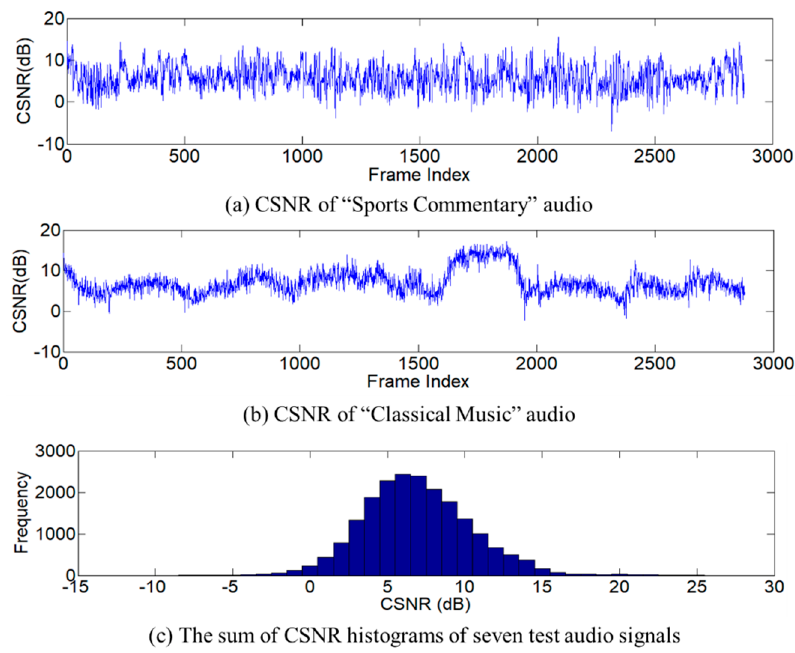
Figure 8. Calculated CSNR of test audio ( a ) CSNR of “Sports Commentary” audio. ( b ) CSNR of “Classical Music” audio. ( c ) The sum of CSNR histograms of seven test audio signals.